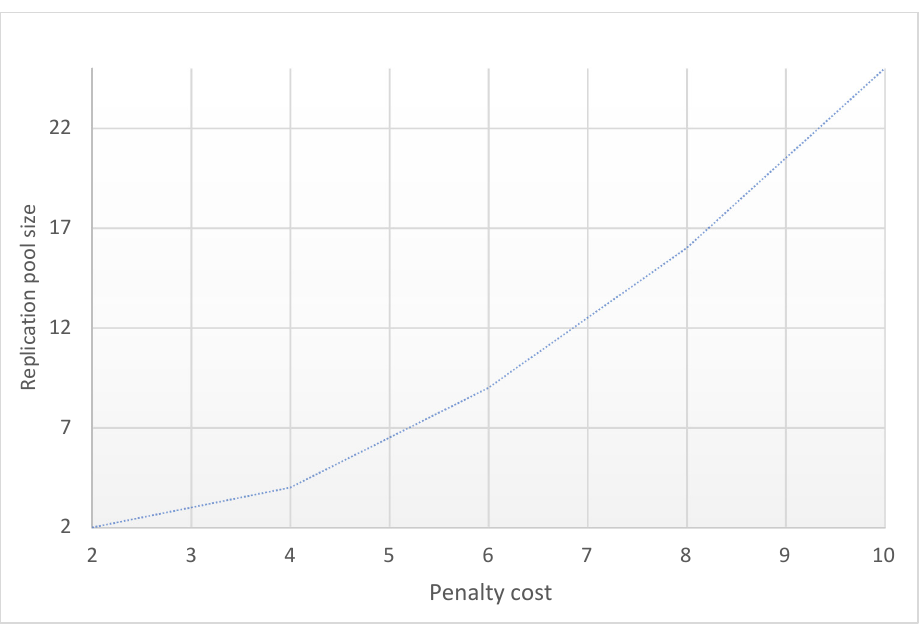
Figure 4. Pool size under different values of penalty cost.